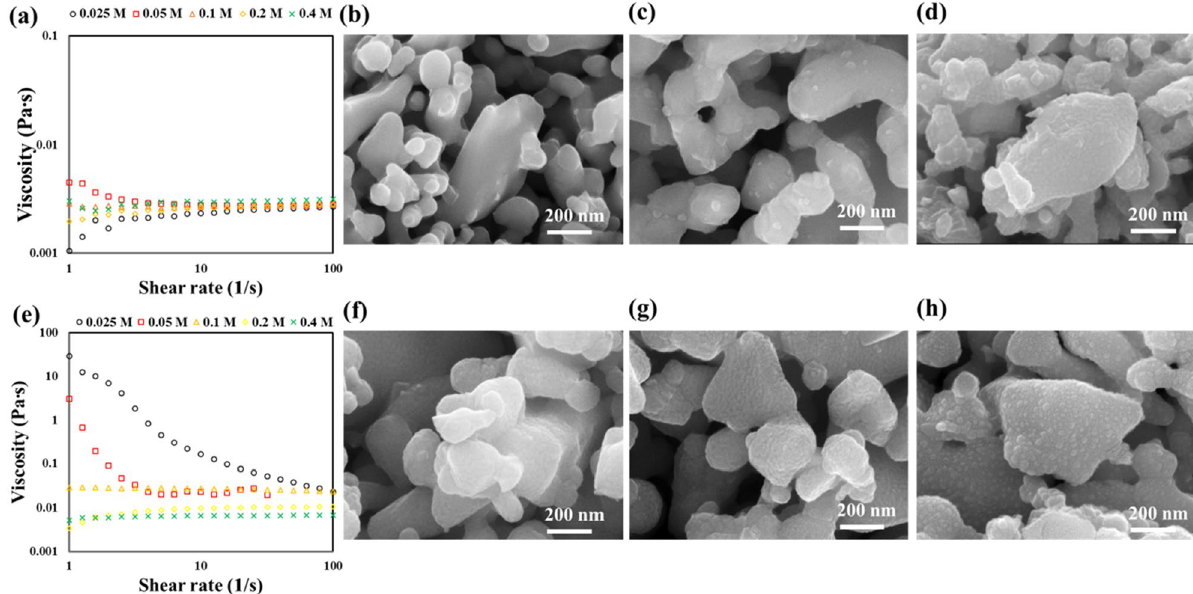
Figure 2. Viscosity of ( a ) glycine solution, and ( e ) gelatin solution, according to GDC precursor mole concentration. SEM images of the coating morphology from glycine/GDC (top) and gelatin/GDC (bottom) infiltration with the concentration of ( b ) and ( f ) 0.025 M, ( c ) and ( g ) 0.05 M, and ( d ) and ( h ) 0.4